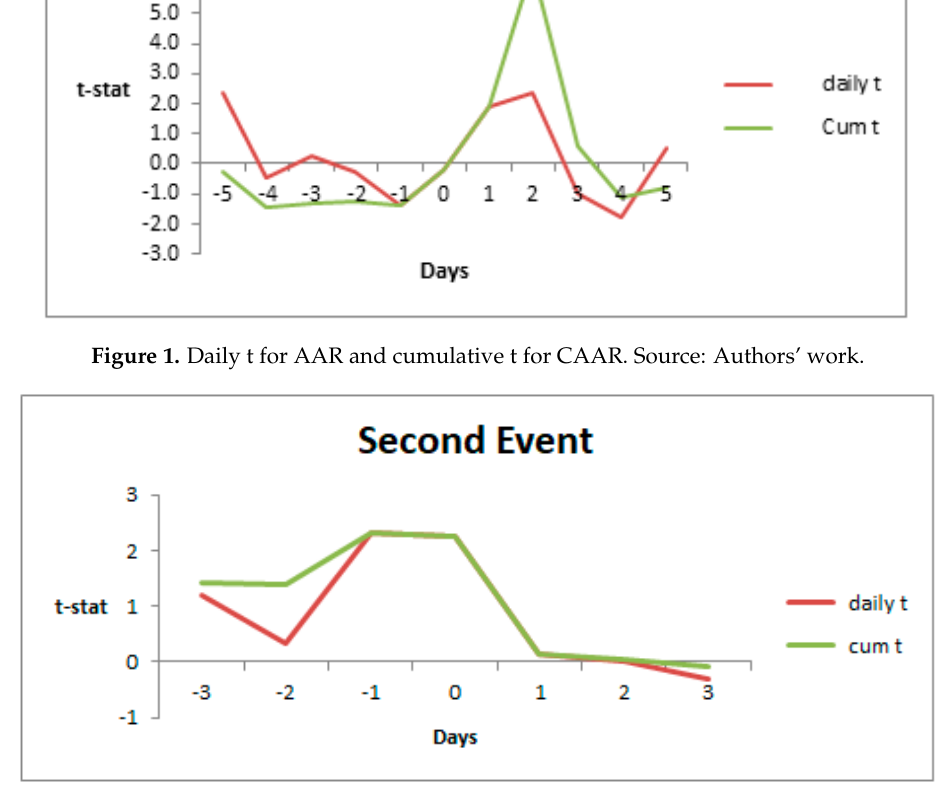
Figure 2. Daily t for AAR and cumulative t for CAAR. Source: Authors’ work.